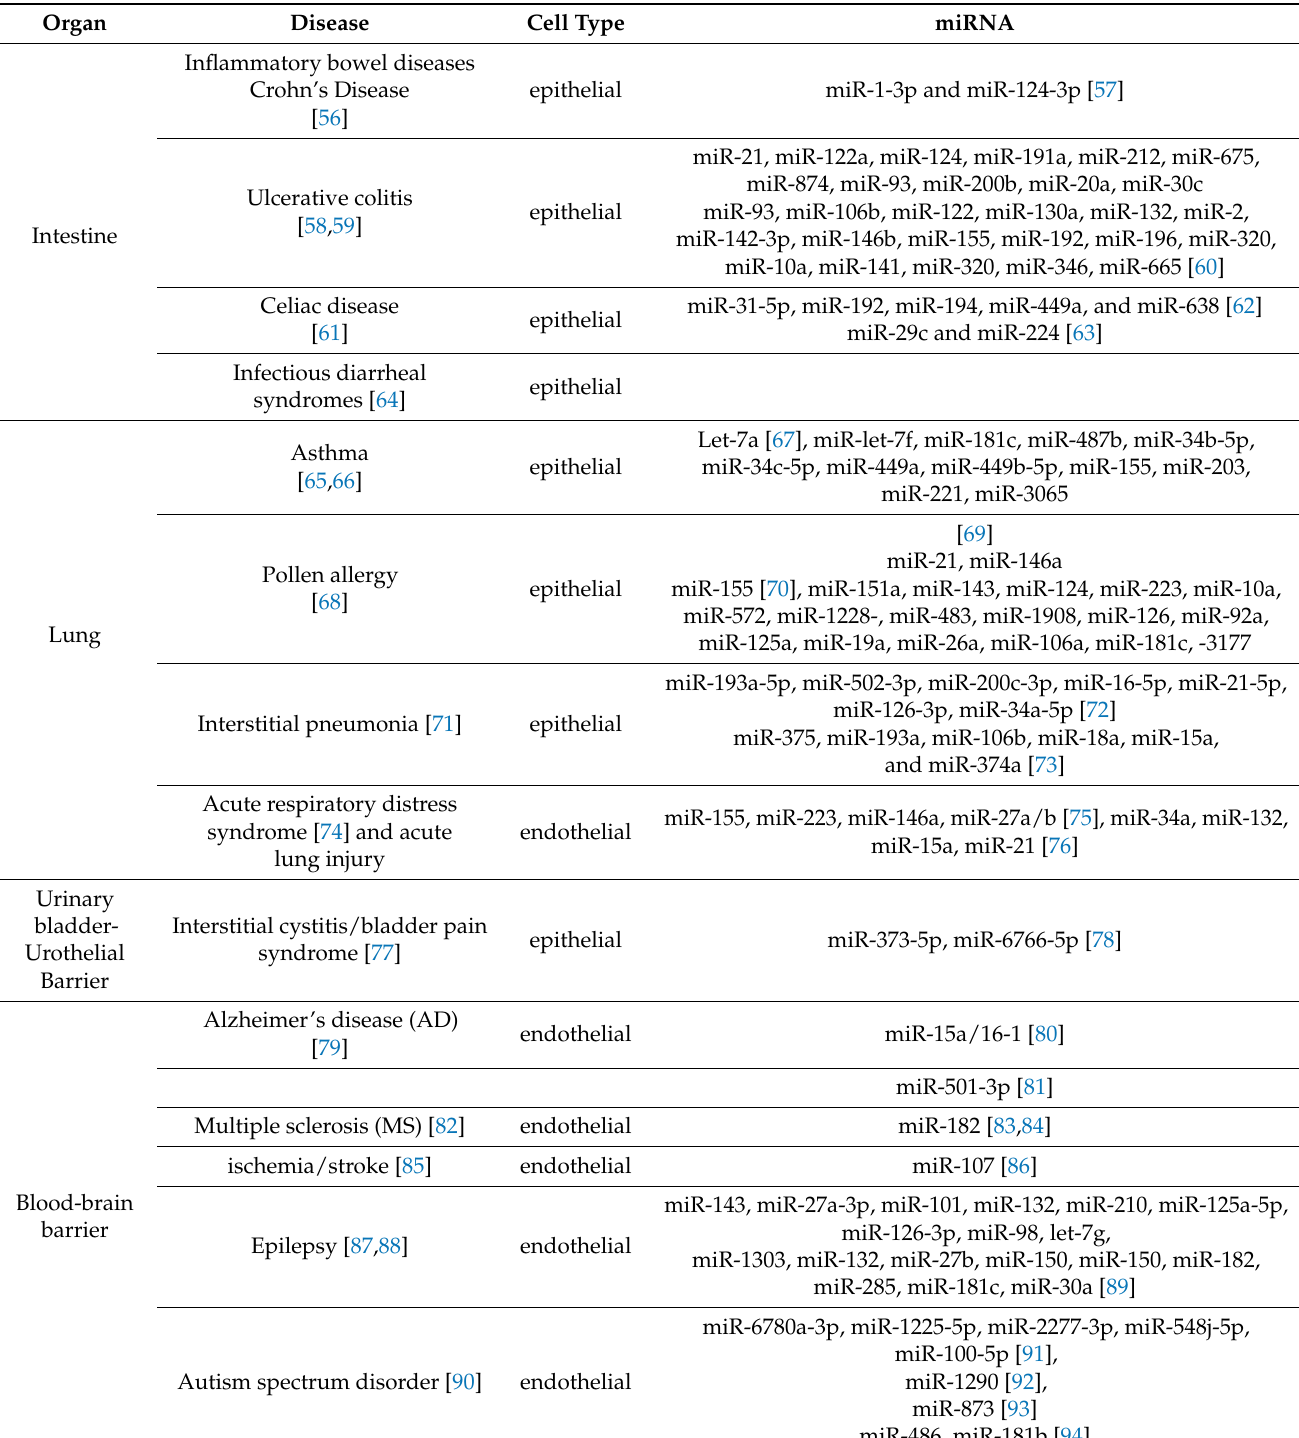
Table 3. Barrier function diseases and